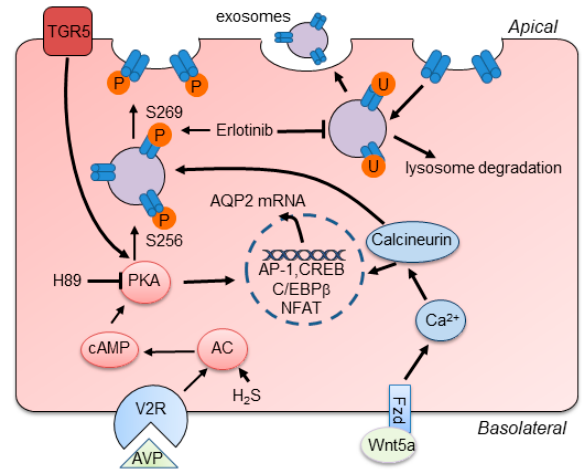
Figure 2. Schematic summary of main regulatory mechanisms of AQP2. AVP binding to V2R stimulates the activation of canonical cAMP/PKA signaling and increases the expression and phosphorylation of AQP2 at S256 and S269, leading to the apical membrane trafficking of AQP2. Activation of TGR5 increases the activation of PKA to induce the expression of AQP2. H 2 S increases AQP2 expression via enhancing the activation of cAMP/PKA signaling. Besides, Wnt5a binds to Fzd receptors and increases the level of intracellular calcium, which stimulates calcineurin and increases the expression and phosphorylation of AQP2. Erlotinib promotes AQP2 expression in the apical membrane by increasing the phosphorylation of AQP2 and reducing its endocytosis and degradation. The translocation of AP-1, CREB, C/EBP β , and NFAT into the nucleus regulates the expression of AQP2.